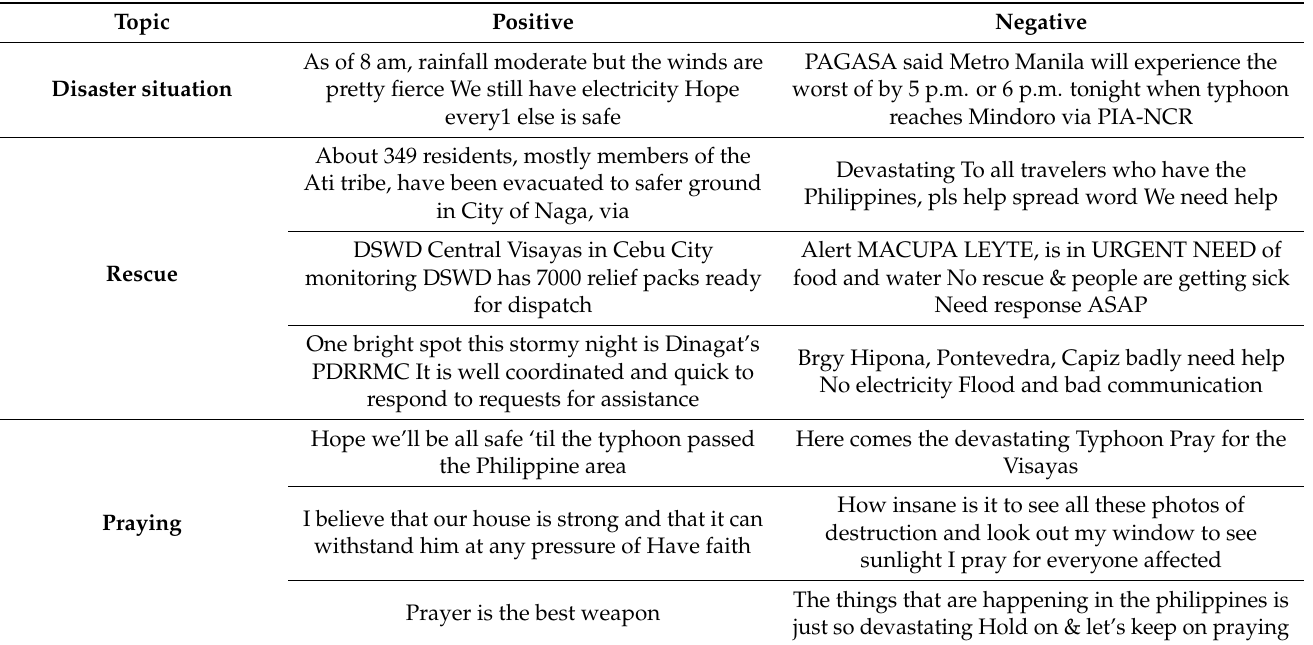
Table 3. Examples of tweets with similar topics in positive and negative